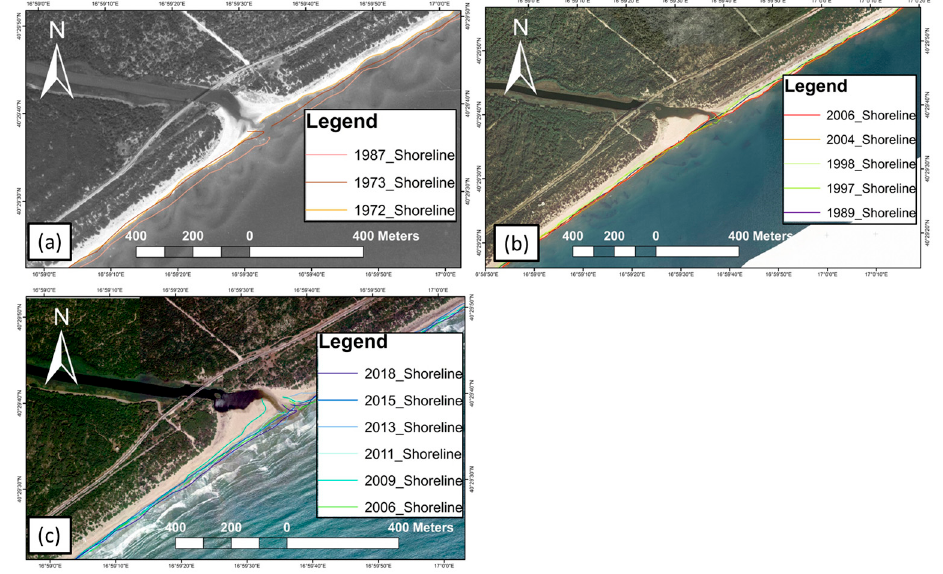
Figure 14. Shoreline changes close to the Lato River mouth; ( a ) 1972 basemap with 1972–1987 super-imposed shorelines; ( b ) 2006 basemap with 1989–2006 super-imposed shorelines; ( c ) 2013 basemap with 2006–2018 super-imposed shorelines.